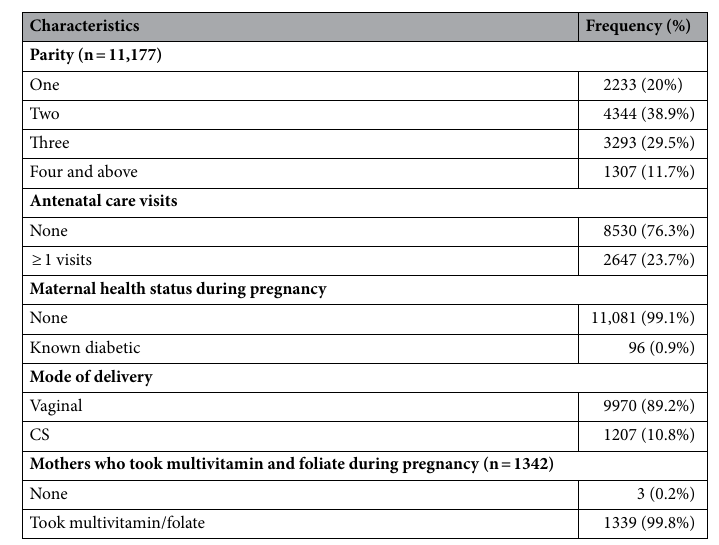
Table 2. Reproductive characteristics of newborn baby’s mothers delivered at Felege-Hiwot Comprehensive Specialized Referral hospital, from Sept. 2009 to Aug. 2014, Bahir Dar, Ethiopia.